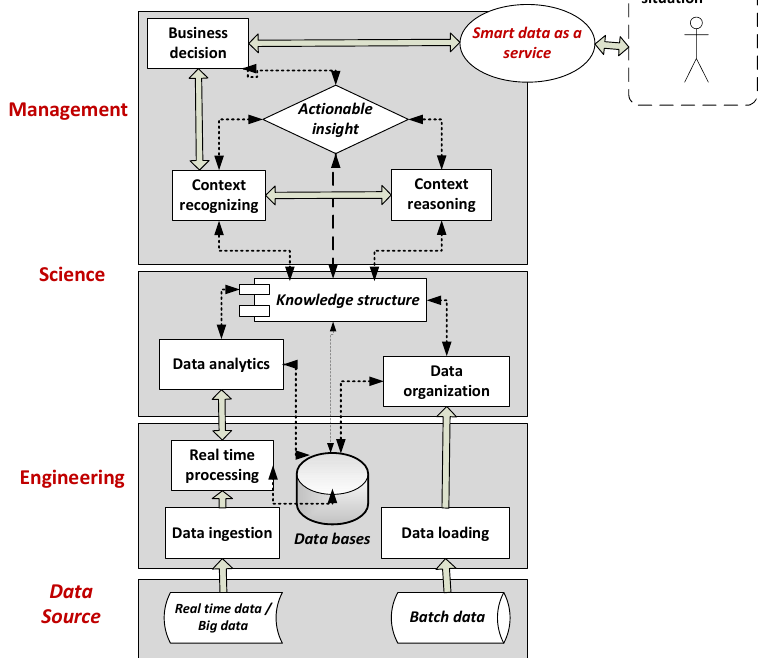
Fig. 1. Conceptual model for smart data